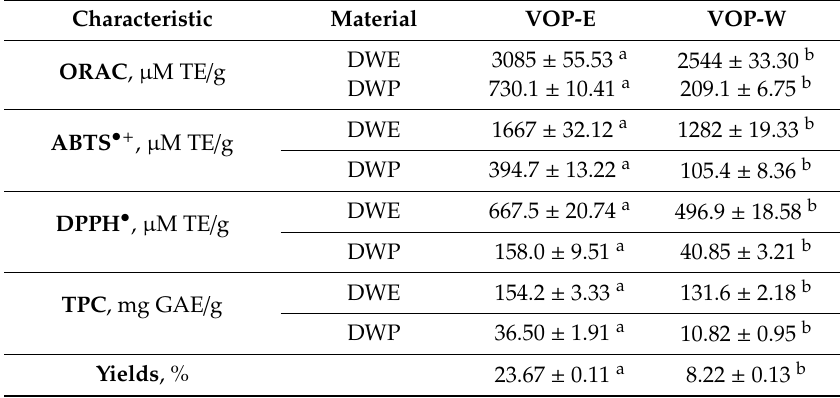
Table 1. Yield, total phenolic content, and antioxidant capacity of guelder rose berry pomace extracts. Characteristic Material VOP-E